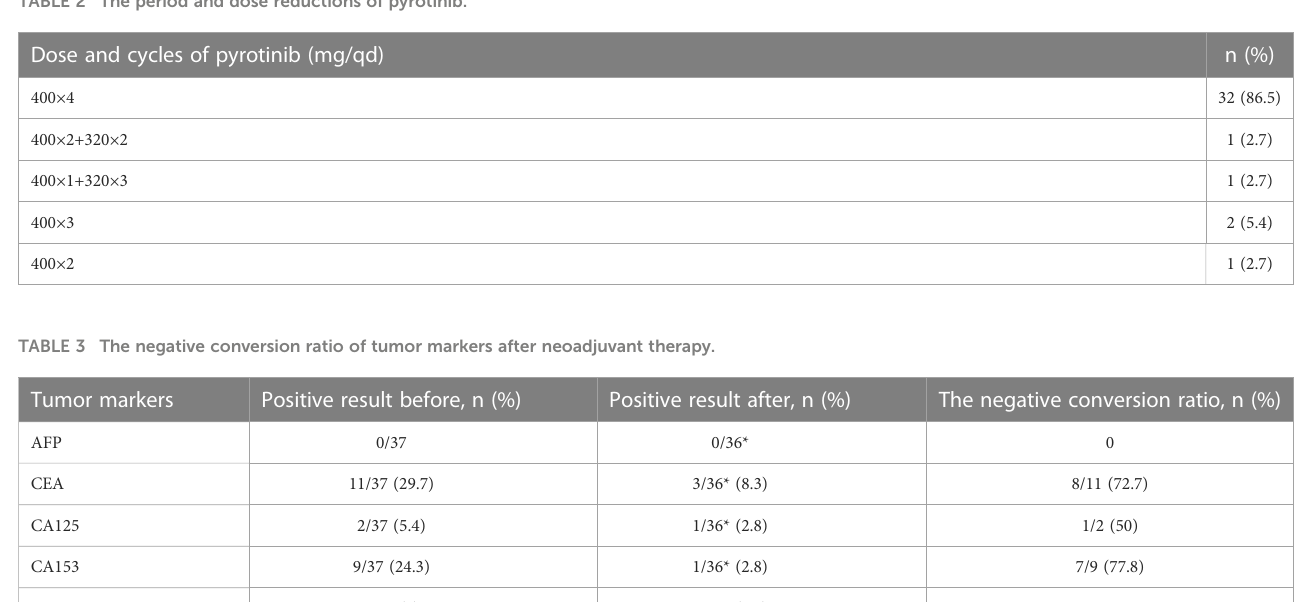
TABLE 2 The period and dose reductions of pyrotinib.